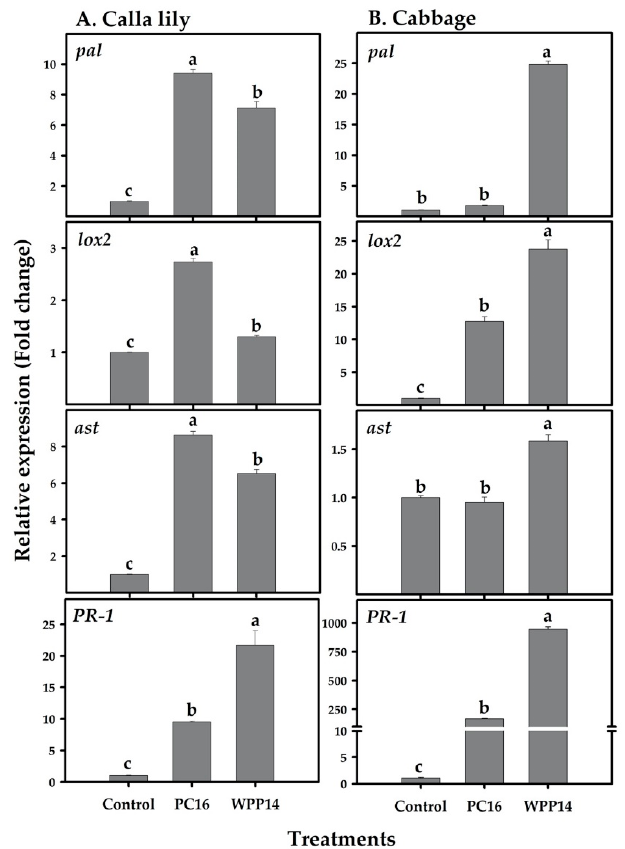
Figure 4. Expression of defense-related genes pal , lox2 , ast and PR-1 in ( A ) calla lily and ( B ) cabbage following infection with Pectobacterium strains PC16 or WPP14. Calla lily and cabbage leaves were infiltrated with overnight-grown Pectobacterium strains (100 µ L, 10 7 cfu / mL in sterile DDW) or sterile DDW. Twenty-four hours after infiltration, the transcript levels of these genes were determined by qRT-PCR using cDNA-specific primers and expressed relative to control. Experiments were repeated three times with three replicates per experiment. Bars represent mean ± SE of relative expression of each gene. Bars not labeled with the same letter (a–c) are significantly di ff erent from each other (one-way ANOVA with post hoc Tukey HSD test, p <